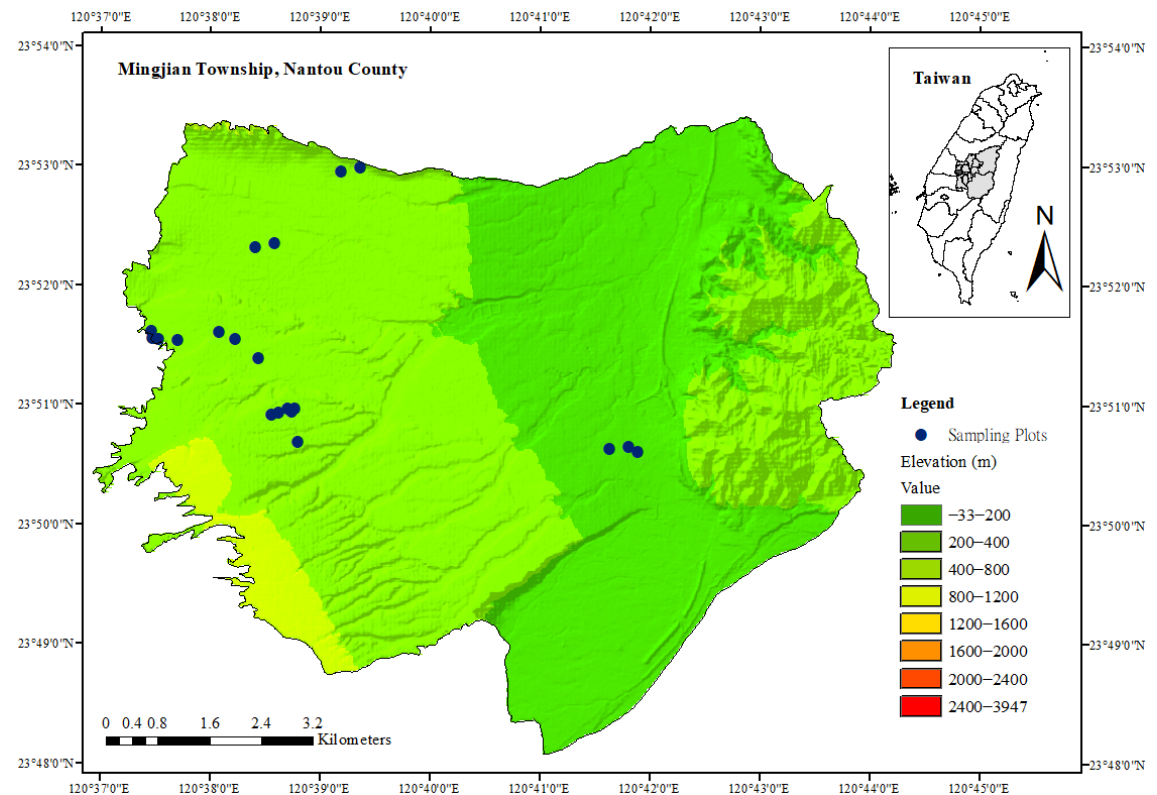
Figure 1. The map of soil sampling sites in Mingjian township, Nantou county, Taiwan that were generated via ArcGIS. (https://www.esri.com/en-us/arcgis/products/arcgis-desktop/overview; mapped on 7 January 2022).